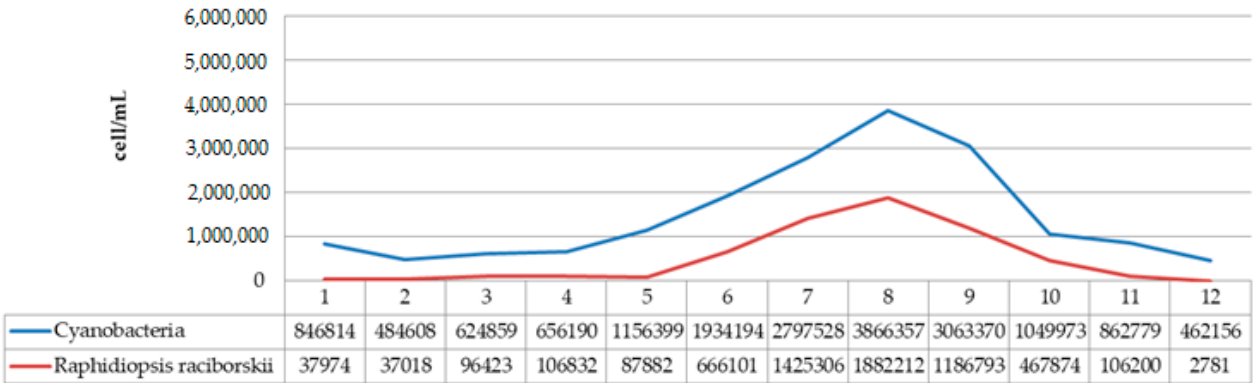
Figure 11. Dynamics of the average cell number of cyanobacteria compared to abundance of R.